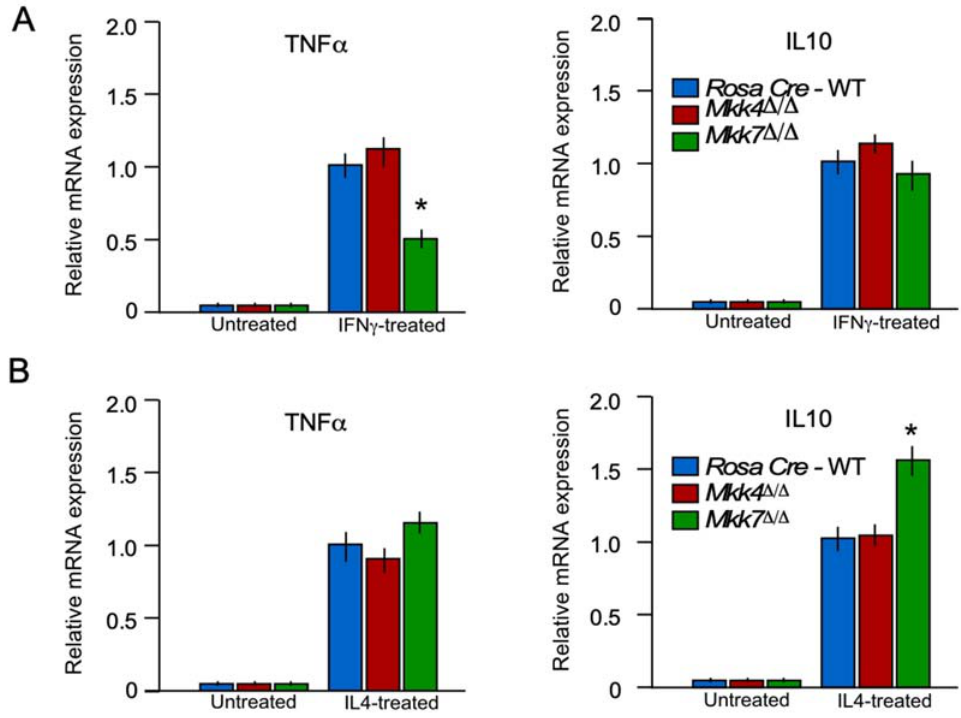
Figure 6. MKK7 is required for macrophages polarization. ( A ) Total RNA was isolated from BMDM incubated (8 h) with- out or with 100 ng/mL IFN γ . The relative mRNA expression of M1 (TNF α ) and M2 (IL10) markers were measured by RT- qPCR assays. ( B ) Total RNA was isolated from BMDM incubated with, or without, 10 ng/mL IL4 (24 h). The relative mRNA expression of the M1 (TNF α ) and M2 (IL10) markers were measured by RT-qPCR assays. Statistically significant differ- ences between groups are indicated (mean ± S.E.M.; n = 4–6; * p < 0.05). All the experiments were repeated 3–4